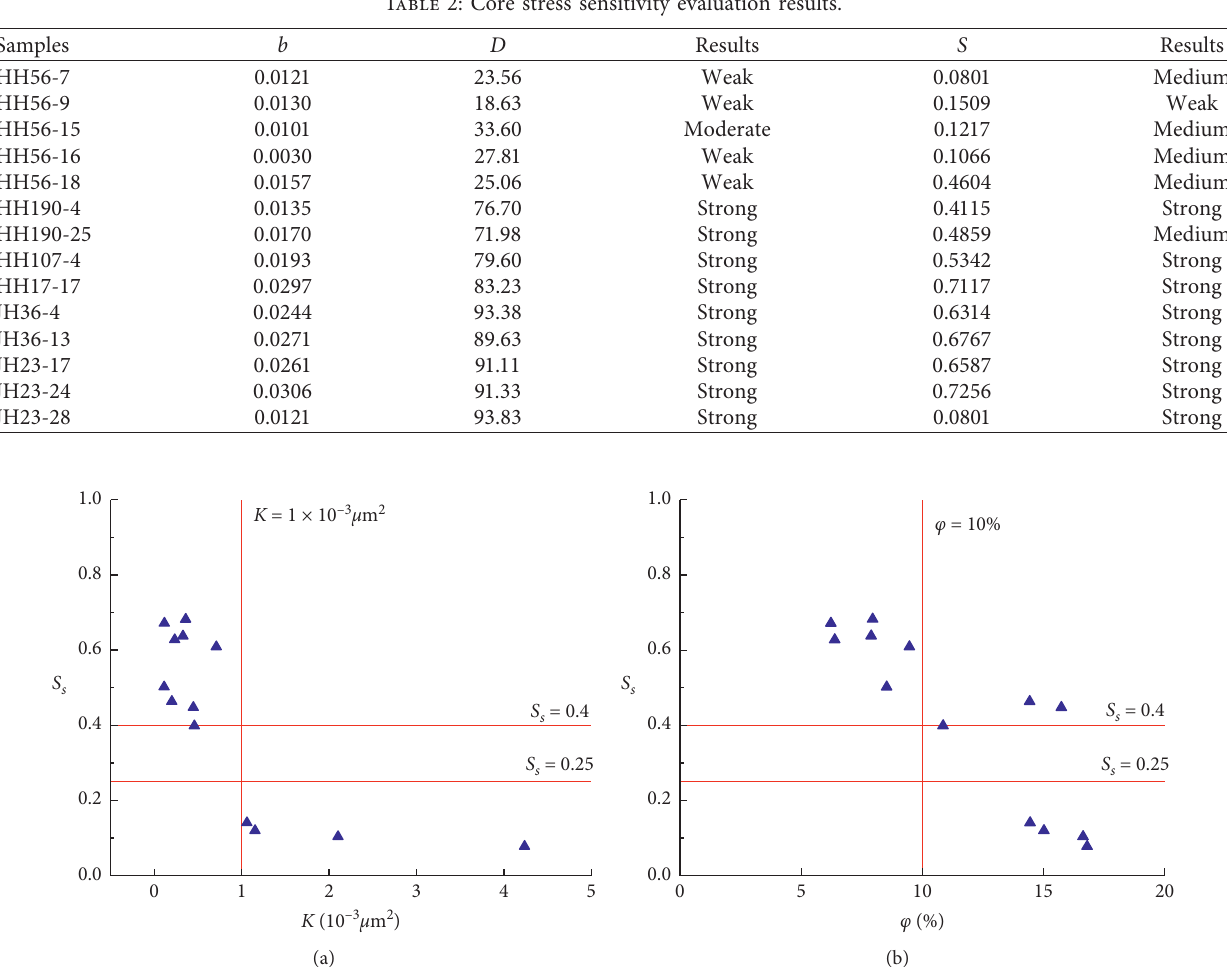
Figure 6: Core sample stress sensitivity coefficient and permeability and porosity intersection diagram. (a) Relationship between per- meability ( K ) and stress sensitivity coefficient ( S s ). (b) Relationship between porosity ( φ ) and stress sensitivity coefficient ( S s